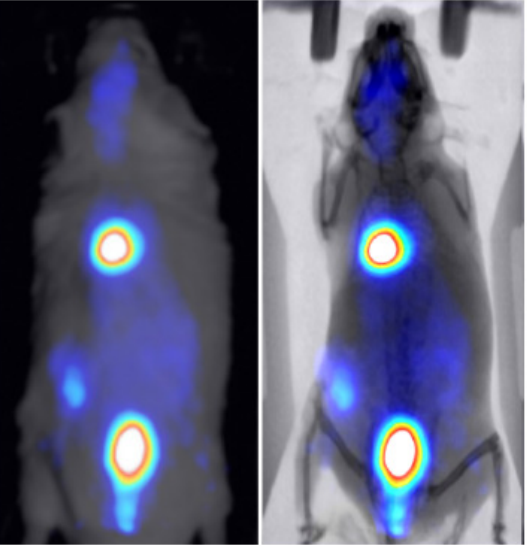
Figure 8. 18 F -FDG nuclear image of a healthy mouse fused with the optical image provided in the β -eye planar coincidence imaging system ( left ) and the X-ray produced from the pix2pix trained network ( right